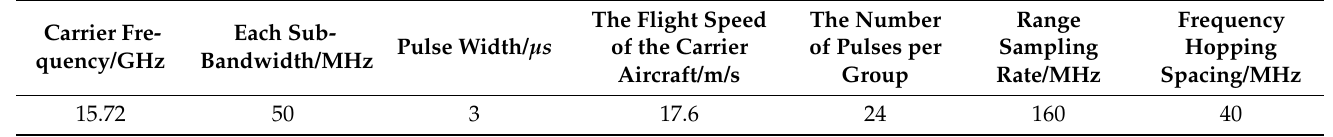
Table 2. SFCWSAR system